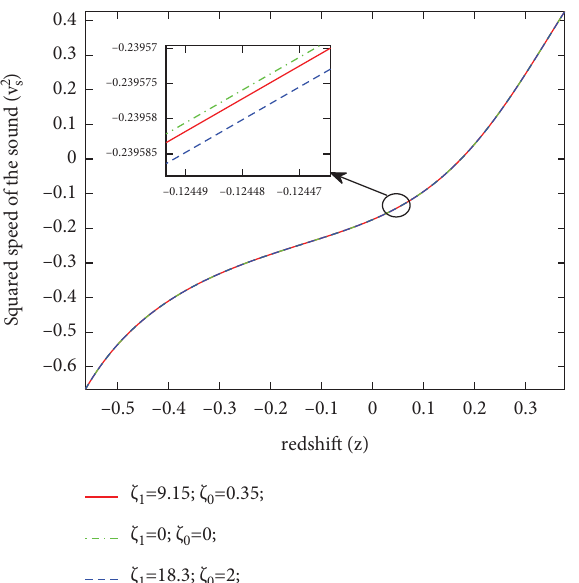
Figure 24: Squared speed of sound ( v 2 IX.